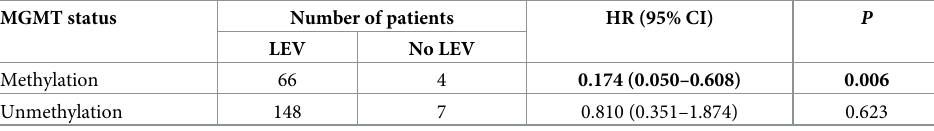
Table 4. Comparison of survival risks using LEV and MGMT promoter